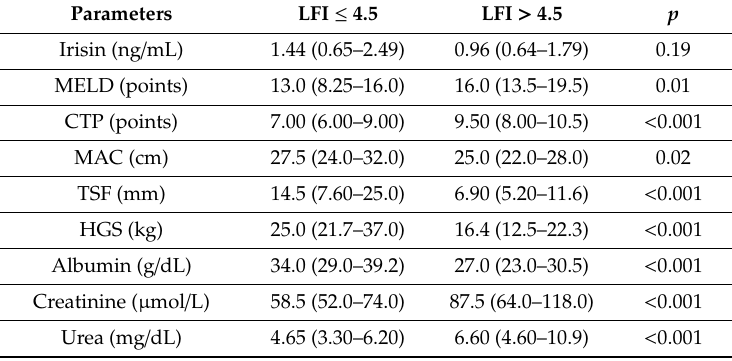
Table 6. Comparison of analyzed parameters between cirrhotic patients with di ff erent LFI value.